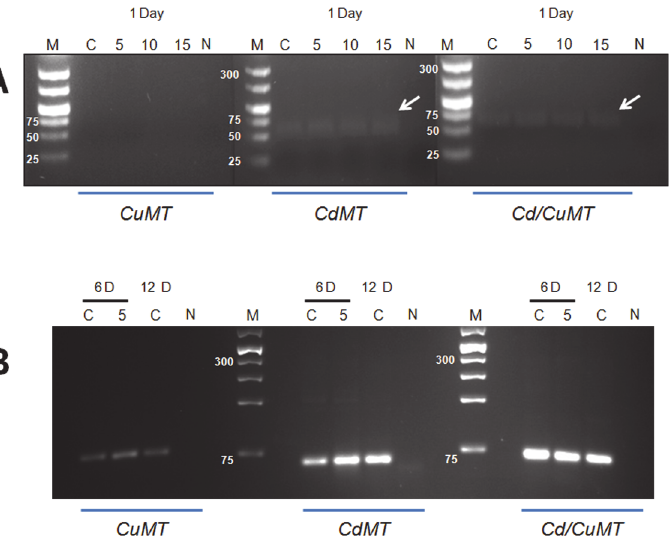
Fig 2. Visualization of PCR amplification bands specific for the three MT isoform genes ( CuMT , CdMT and Cd/CuMT ) of Cantareus aspersus control and Cd-exposed embryos. (A) Detection of MT isoform gene amplification bands in 1-day-old control eggs (C) and embryos exposed for one day to increasing Cd concentrations (5, 10, and 15 mg/L) (5, 10, 15), along with DNA ladder bands (M) (Generuler Low range DNA ladder and 100pb plus DNA ladder, Thermo Scientific) on 3% agarose gel. N, negative control without sample DNA. (B) Detection of MT isoform gene amplification bands in 6-day-old control (C) embryos and embryos exposed to 5 mg Cd/L (5), or in 12-day-old embryos (C, controls only), along with DNA ladder bands (M) (Generuler Low range DNA ladder and 100pb plus DNA ladder, Thermo Scientific) on 3% agarose gel. N, negative control without sample